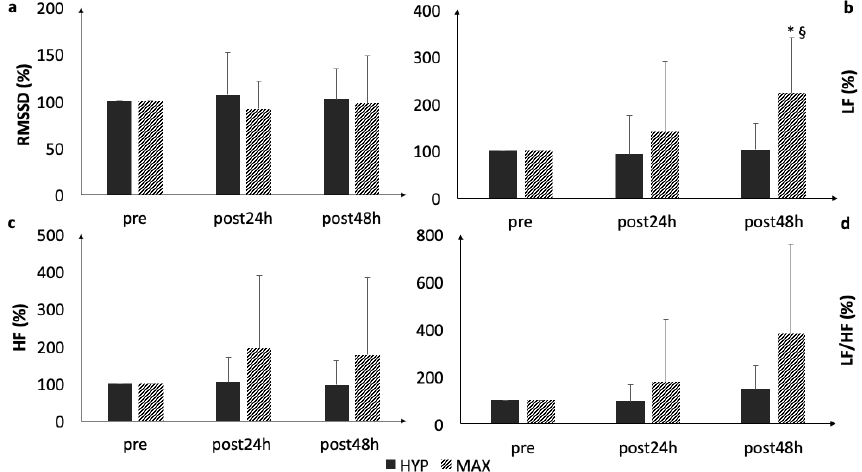
Figure 2. Comparison of ( a ) RMSSD, ( b ) LF, ( c ) HF, and ( d ) LF / HF as measured during the orthostatic tests. * statistically significant difference to baseline ( p < 0.05); §, statistically significant group difference.